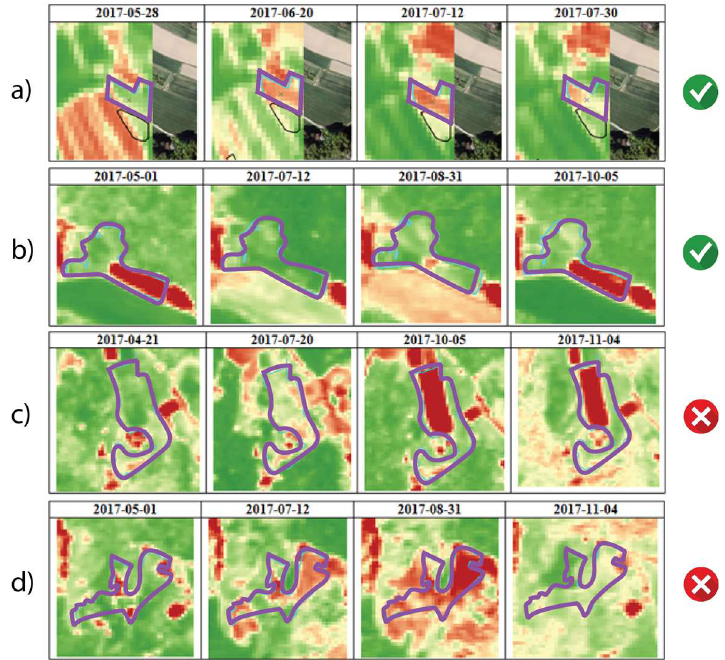
Figure 12. Series of S-2 subsets of permanent meadows, where the phenomena of anomalies in land use management was detected, indicated with red colors. Red represents low NDVI values and inactive or less active vegetation. The first two examples ( a and b ) reveal the discrepancy between national land use databases—no actual irregularities (green check), whereas the last two ( c and d ) show actual irregularities in the land use (warning red cross).